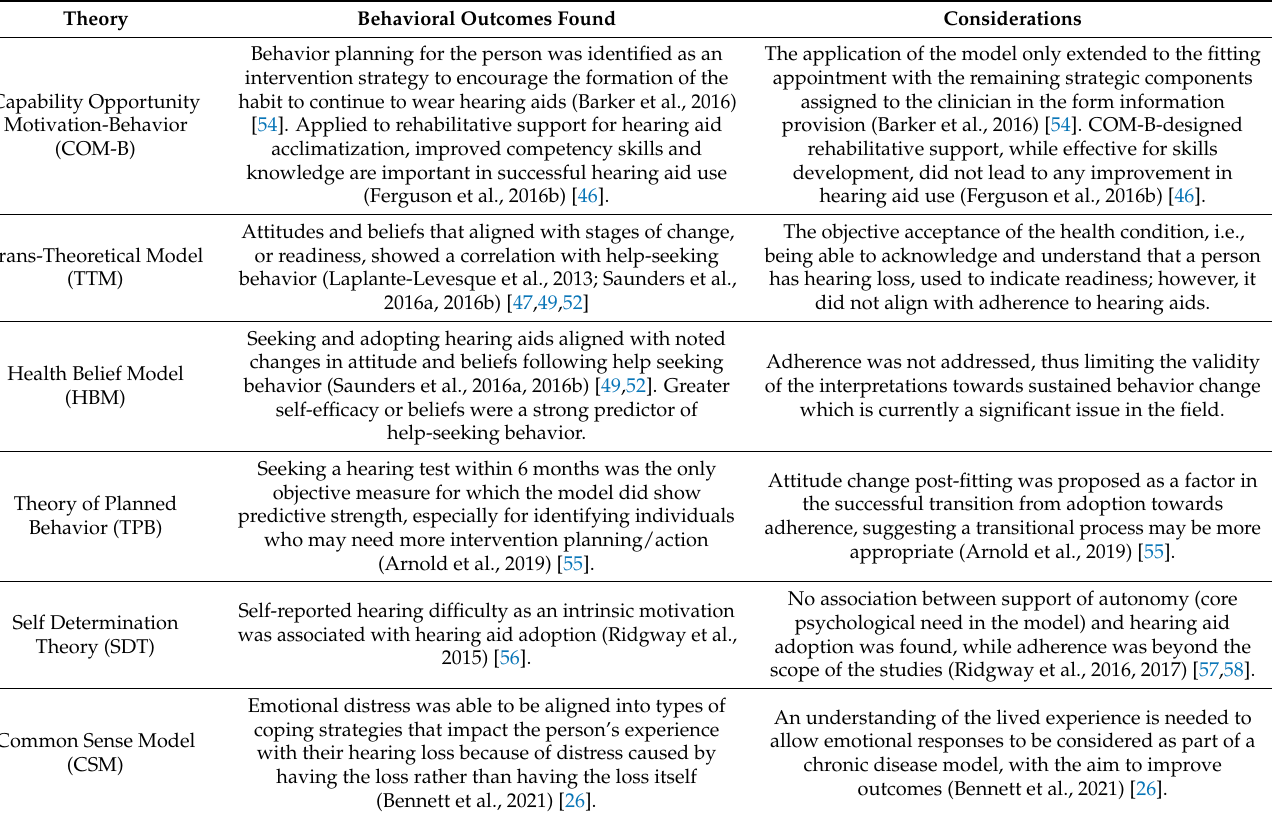
Table 2. Applications of behavior change models in Audiology